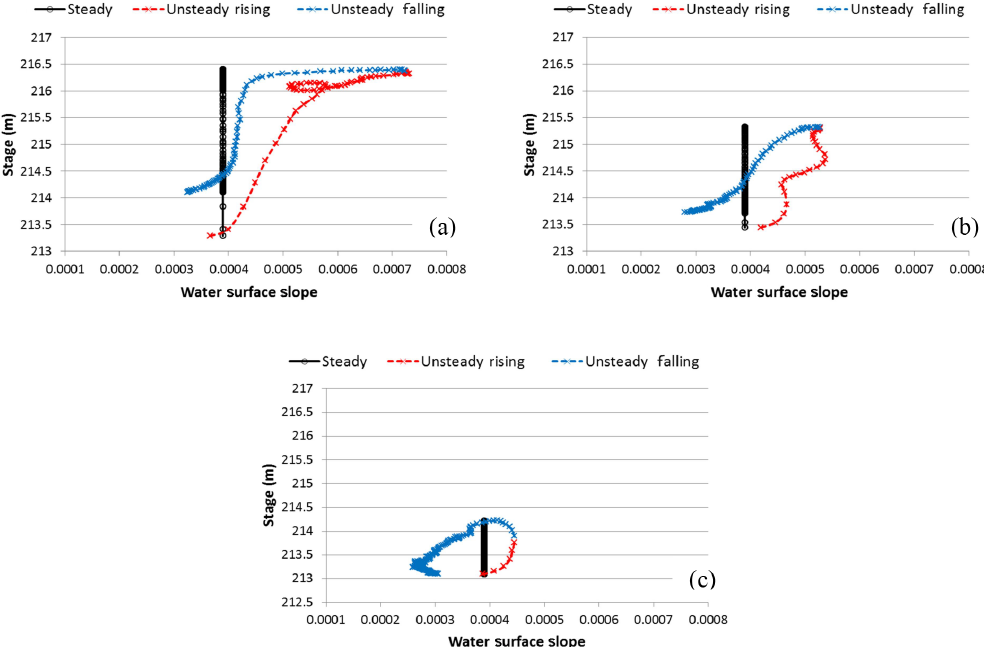
Figure 6. Measured hysteretic behavior of water surface slopes for the selected three events: (a) Event 1, (b) Event 2, and (c) Event 3. The horizontal axis represents estimated water surface slopes between transducers and the vertical axis represents stages at the downstream